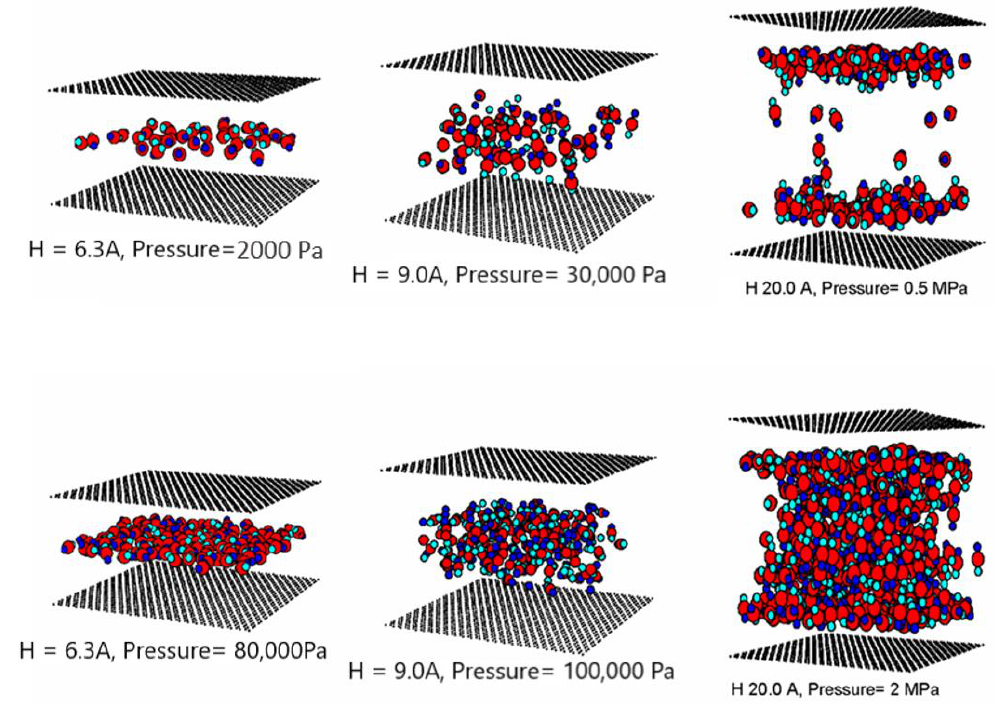
Figure 12. Snapshots of CO 2 in 6.3, 9 and 20 Å pores at 273